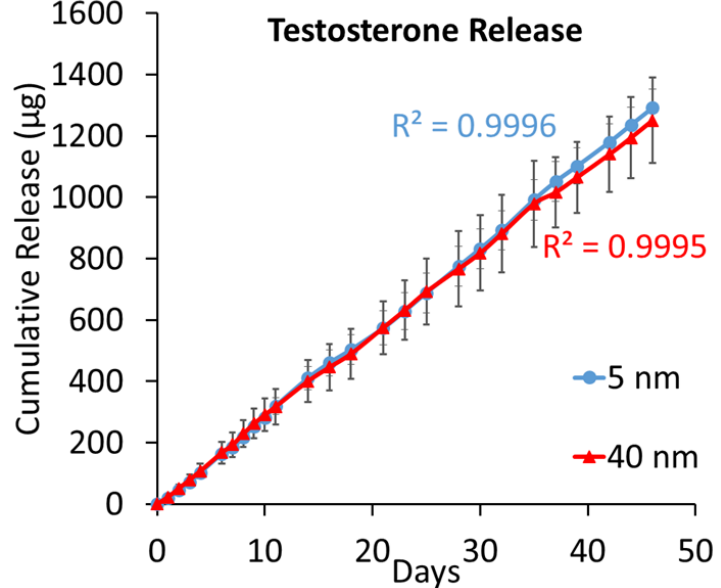
Figure 5. Average cumulative release of testosterone for both 5 (blue) and 40 (red) nm nanochannel membranes. The grey lines highlight the standard deviation. Theoretical fitting value is report for both nanochannel membranes. The